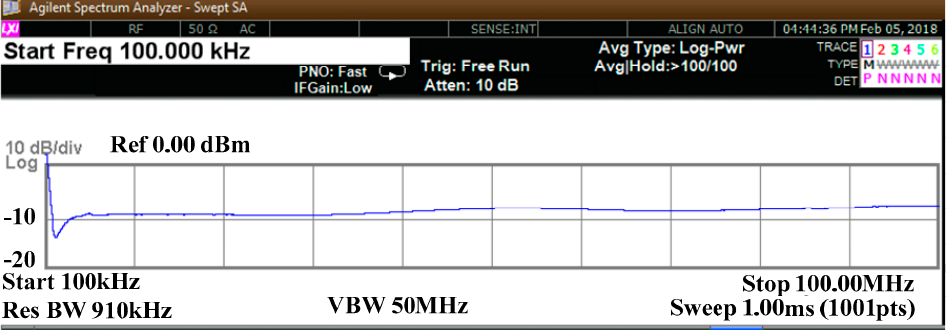
Figure 3. Output characteristic of an iHFCT-54 sensor.